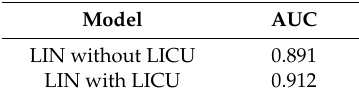
Table 5. AUC of frameworks with/without